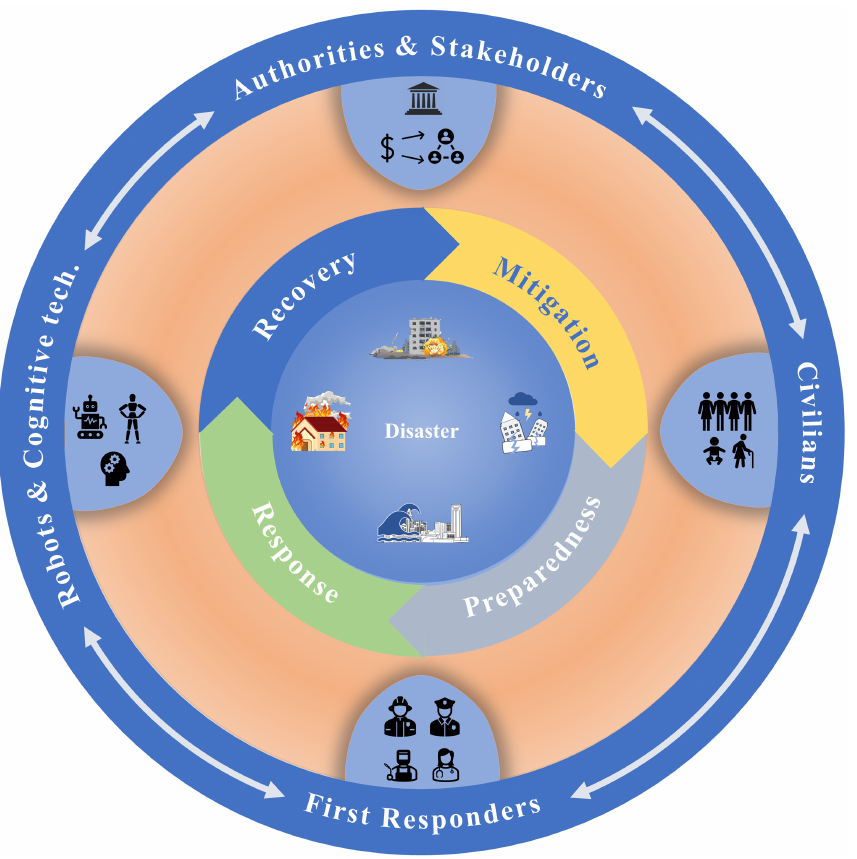
Figure 2. This diagram illustrates a framework for emergency management with four phases and various components included in every phase.